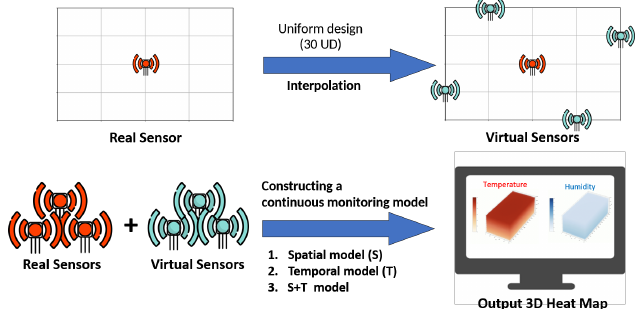
Figure 5. Continuous Monitoring Architecture.